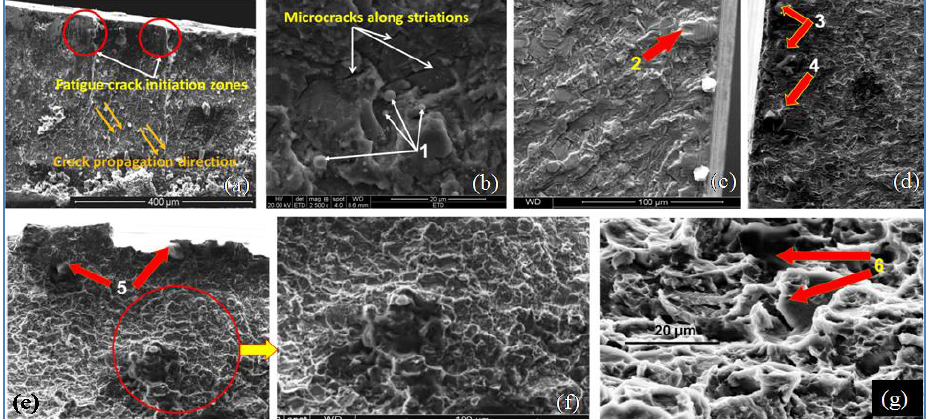
Fig. 6: Fractographs of shaft 1at different locations – (a-d) fatigue fractured regions, (e-g) overload failure.